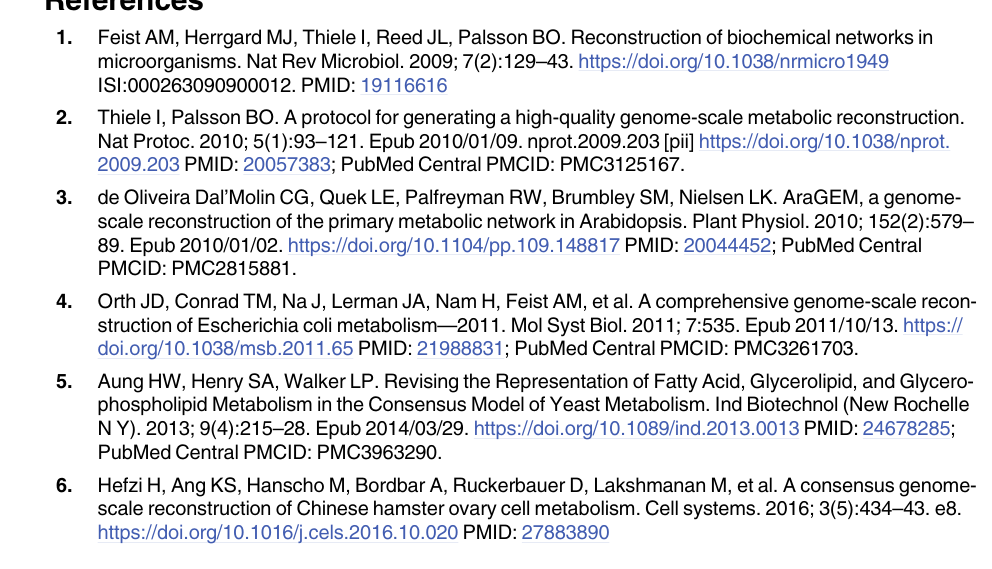
removed from reactions (in S1 Table). Table K: Reversible reactions with and without cur- rency metabolites of E . coli iJO1366 model (in S1 Table). Table L: Reversible reactions with and without currency metabolites of Recon 2.2 model (in S1 Table) Table M: Cliques distri- bution for different correlation thresholds in the largest metabolic modules of the iJO1866 model (in S1 Table). S1 Data. Code to calculate correlations and visualise the data. S2 Data. Correlations computed for Human Recon 2.2. Code to process large TPM files from the GTEx (The Genotype-Tissue Expression) project and produce correlation